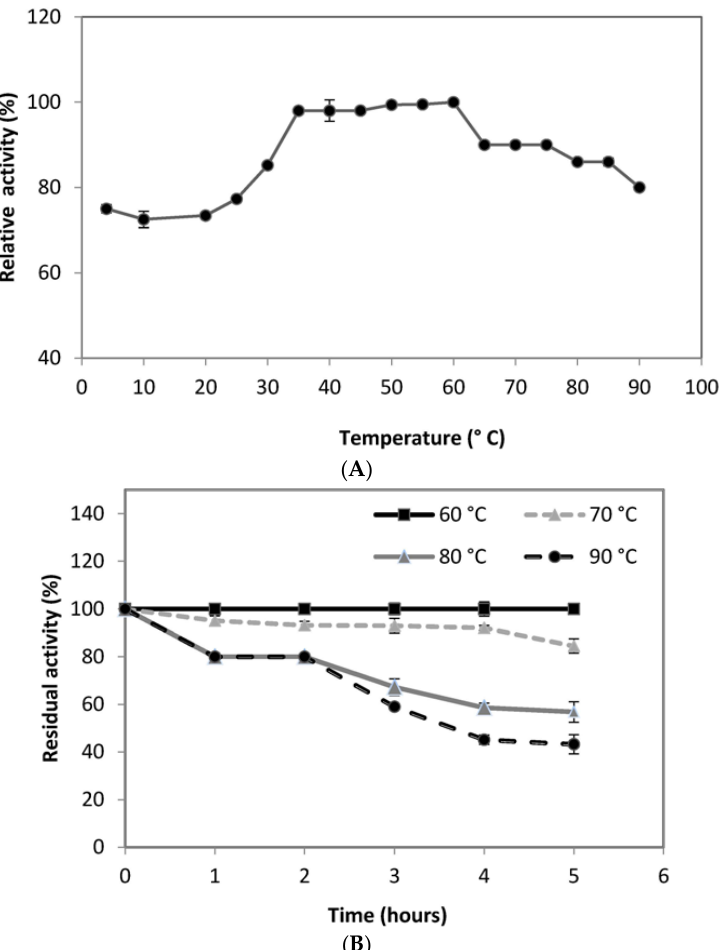
Figure 5. Effect of temperatures on the activity ( A ) and stability ( B ) of PG from A. pullulans isolated strain. Each point represents the mean ( n = 3) ± standard deviation.